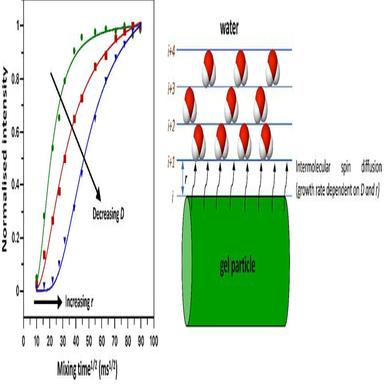
Schematic representation of the grid approximation of the spin diffusion model (right) and the influence of the parameters affecting the growth of the spin diffusion build–up curves (left).